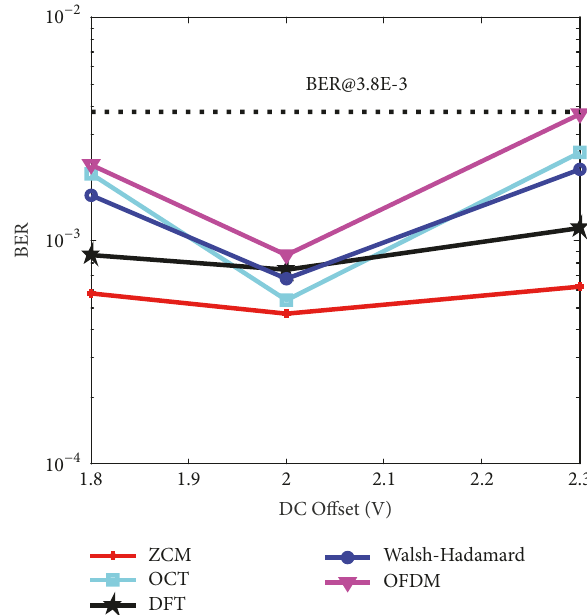
Figure 5: BER versus DC